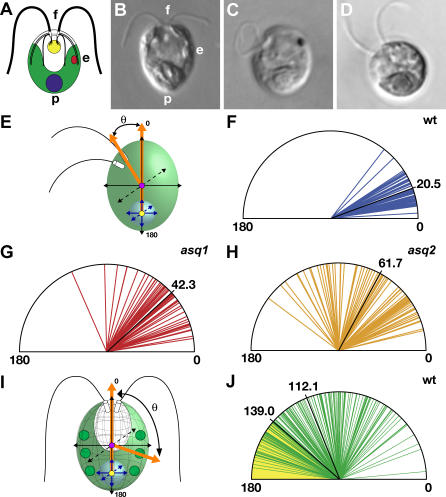
Identification and Quantification of Defects in asq Mutants(A) Chlamydomonas cell geometry. Flagella (f) extend from the centrioles (white), which are located apically and are attached to the nucleus (yellow) by centrin-containing fibers. The pyrenoid (p; blue), a starch-containing structure, is located basally and is embedded in a cup-like mass of chloroplast (green). The eyespot (e; red), the light-sensing organelle, is located laterally at a reproducible angle relative to the centrioles.(B) DIC image of a wt Chlamydomonas cell. The pyrenoid (p), eyespot (e), and flagella (f) are indicated. All DIC images are sections through full 3D datasets.(C) In asq1 cells, mother–daughter centriole pairs are randomly localized on the cell surface.(D) In asq2 cells, centrioles are independently positioned on the cell surface and no longer found in pairs.(E) Defining θcentriole. A 3D vector reflecting the long axis of the cell is drawn from the center of mass (yellow circle) of the pyrenoid (blue) to the cellular center of mass (purple circle). θcentriole is the angle between the vector defining the long axis of the cell and the vector from the cellular center of mass to each centriole (white). All angle measurements are made in three dimensions using 3D image datasets.(F) The mean θcentriole (black line) for wt cells is 20.5 ± 9.0° (n = 62),(G) θcentriole increases to 42.3 ± 21.3° for asq1 cells (n = 54). Angles are biased toward the top half of the cell, presumably because the lower half of the cell is occluded by the chloroplast, which is localized in the basal half of the cell body (see [J]) and closely apposed to the plasma membrane, thus reducing access of basal bodies to the cell surface.(H) θcentriole increases to 61.7 ± 32.3° for asq2 cells (n = 71).(I) Defining θchloroplast. The cell center–pyrenoid axis is defined as described in (E). θchloroplast is defined as the angle between the vector defining the long axis of the cell and the vector from the cellular center of mass to each plastid genome (large green circle).(J) The θchloroplast for wt cells is shown in green (mean = 112.1 ± 36.0°, n = 181). Each line represents the position of one plastid genome. The yellow-shaded area represents the area of the cell occupied by the pyrenoid. The non-180° edge of this shaded region indicates the mean position of the pyrenoid boundary (mean = 139.0 ± 14.4°, n = 90).